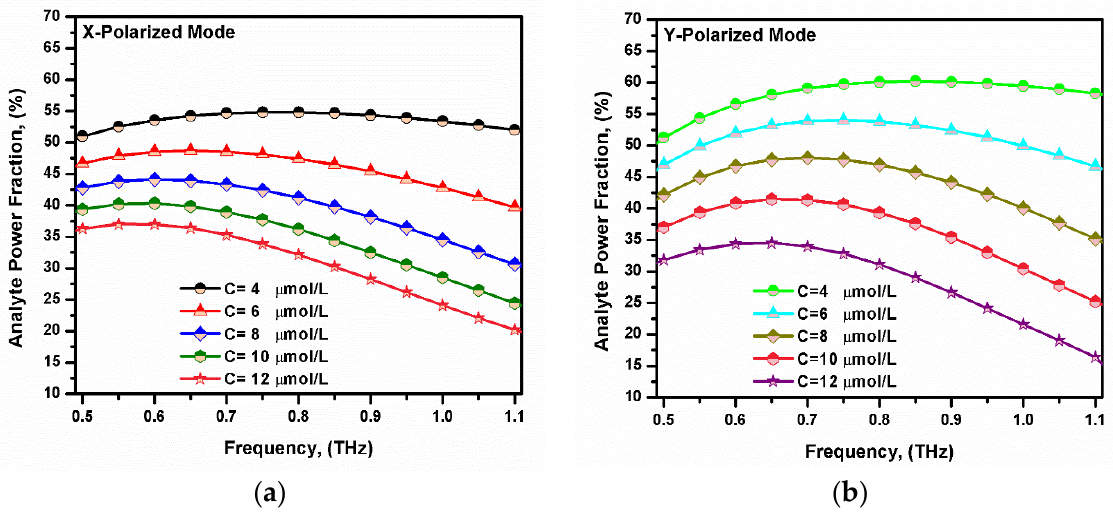
Figure 8. The variation in the power fraction with the frequency for the fundamental ( a ) x-polarized mode and ( b ) y-polarized mode at different bilirubin concentrations.